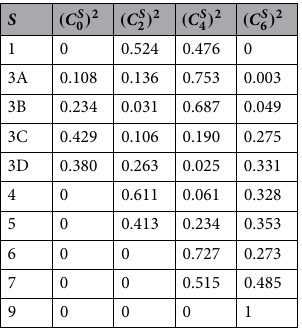
Table 1. The squares of the coefficients ( C the S = 3 states with the parameters given at the points A to D marked in Fig.